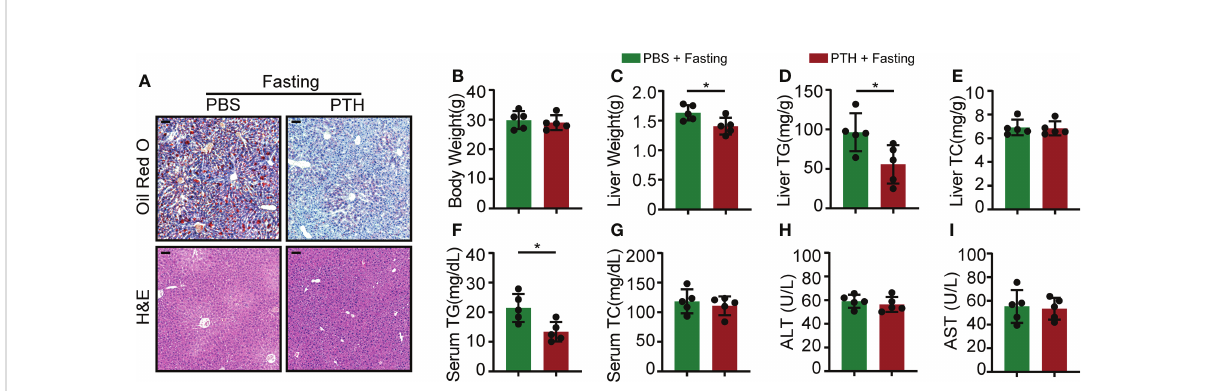
FIGURE 3 The fasting-induced lipid accumulation in the liver of mice was ameliorated by PTH administration. Eight-week-old male C57/BL6 mice were subcutaneously injected with PTH (40 m g/kg daily) or PBS for 2 months, then fasted for 24 hours and sacri fi ced. (A) The Oil Red O and H&E staining of mice liver tissues (Scale bar = 100 m m). (B) Body weight. (C) Liver weight. (D, E) The hepatic TG and TC levels. (F, G) The serum TG and TC levels. (H, I) The serum ALT and AST levels. Data are shown as mean ± SD (n=5/group). *P < 0.05 by two-tailed Student ’ s t-test.